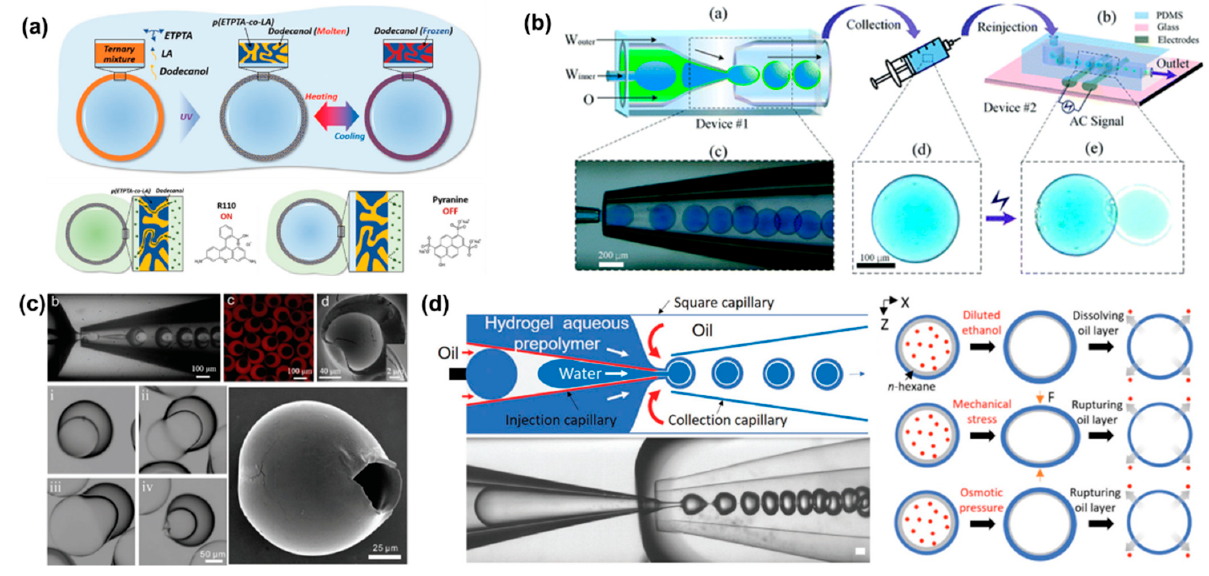
Figure 3. ( a ) Schematic illustration of microcapsule formation by double emulsion droplet templates and reversible phase change of dodecanol in shell voids during heating and cooling. Reproduced with permission [75]. Copyright 2019, Wiley. ( b ) Schematic illustration of co-flow capillary microfluidics chip for encapsulation and controlled release of drugs. The applied electric field can control the release of the internal drug from the microcapsule. Reproduced with permission [77]. Copyright 2018, Royal Society of Chemistry. ( c ) The optical images of capillary microfluidic chip preparation of inhomogeneous microcapsules. Confocal images, SEM images and optical images of inhomogeneous microcapsules. The optical images showed that the thinnest part of the microcapsule shell starts to swell and the volume increased until it ruptures. Reproduced with permission [81]. Copyright 2019, Wiley. ( d ) Schematic and optical image of microfluidic chip to produce microencapsulated cargos with a thin oil layer, where different external stimuli including dissolution, mechanical pressure and osmotic pressure induce destabilization of the interstitial oil layer to release the cargo. Reproduced with permission [76]. Copyright 2021,